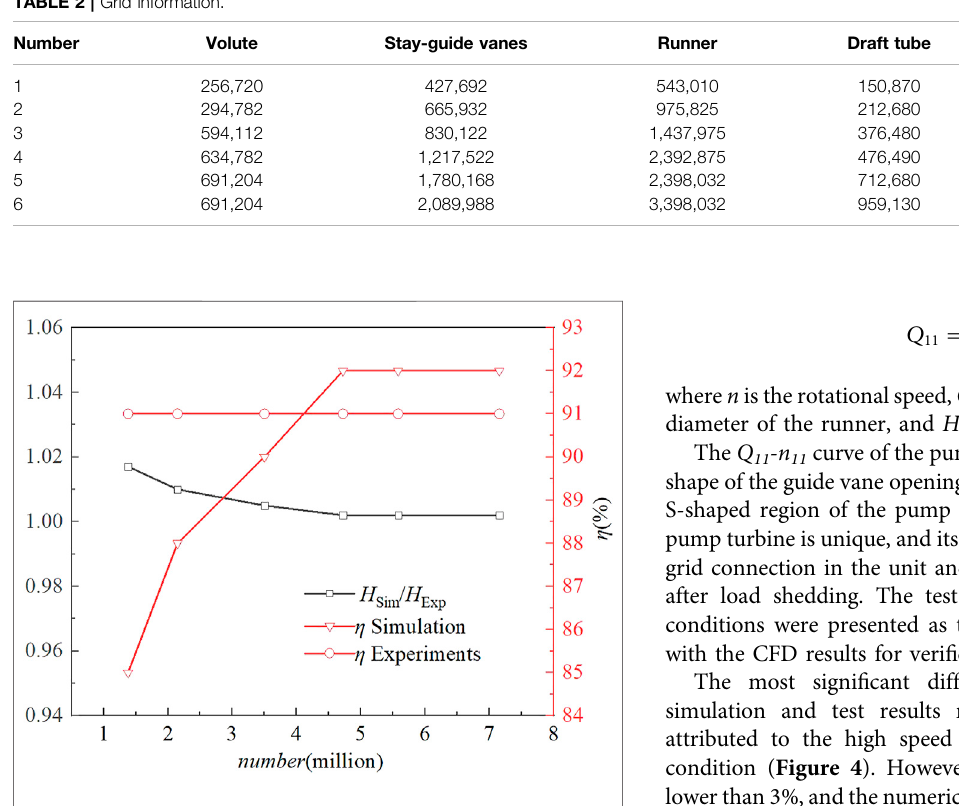
FIGURE 1 | Validation of grid